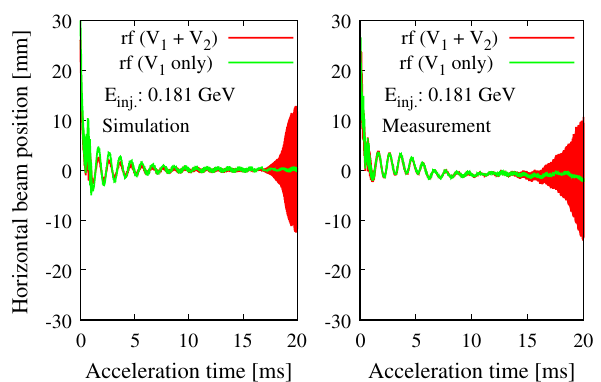
FIG. 15. Simulation results of beam instability growth depend- ence on the transverse injection painting emittances for 0.375 MW beam power and applying only V 1 . In this particular condition with strong space charge effect, the Landau damping effect is quite significant, resulting in no remarkable difference on the beam stability condition within the present variation of transverse beam